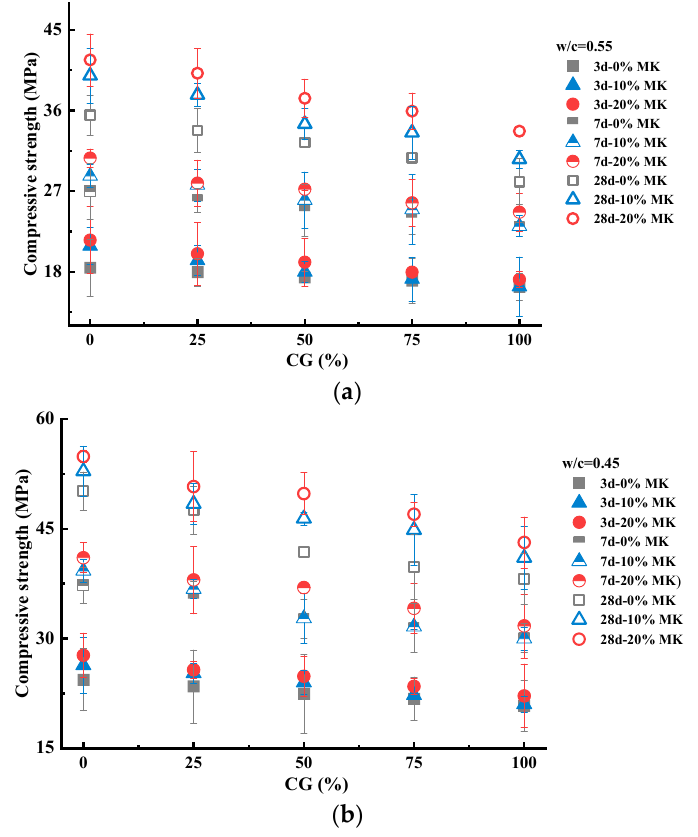
Figure 1. Variation of compressive strength of concrete with CG and metakaolin (( a ). 0.55, ( b ). 0.45).